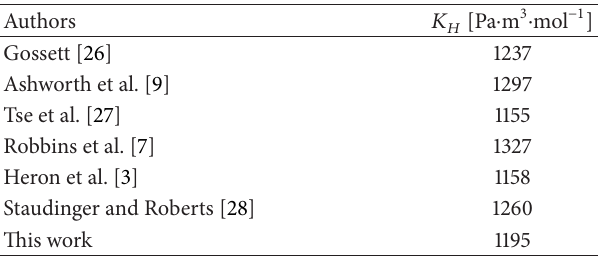
Figure 4: Vapor partial pressure of TCE as a function of its aqueous concentration. Table 3: Values of Henry’s law constant [Pa ⋅ m 3 ⋅ mol −1 ] of TCE at 303 K.